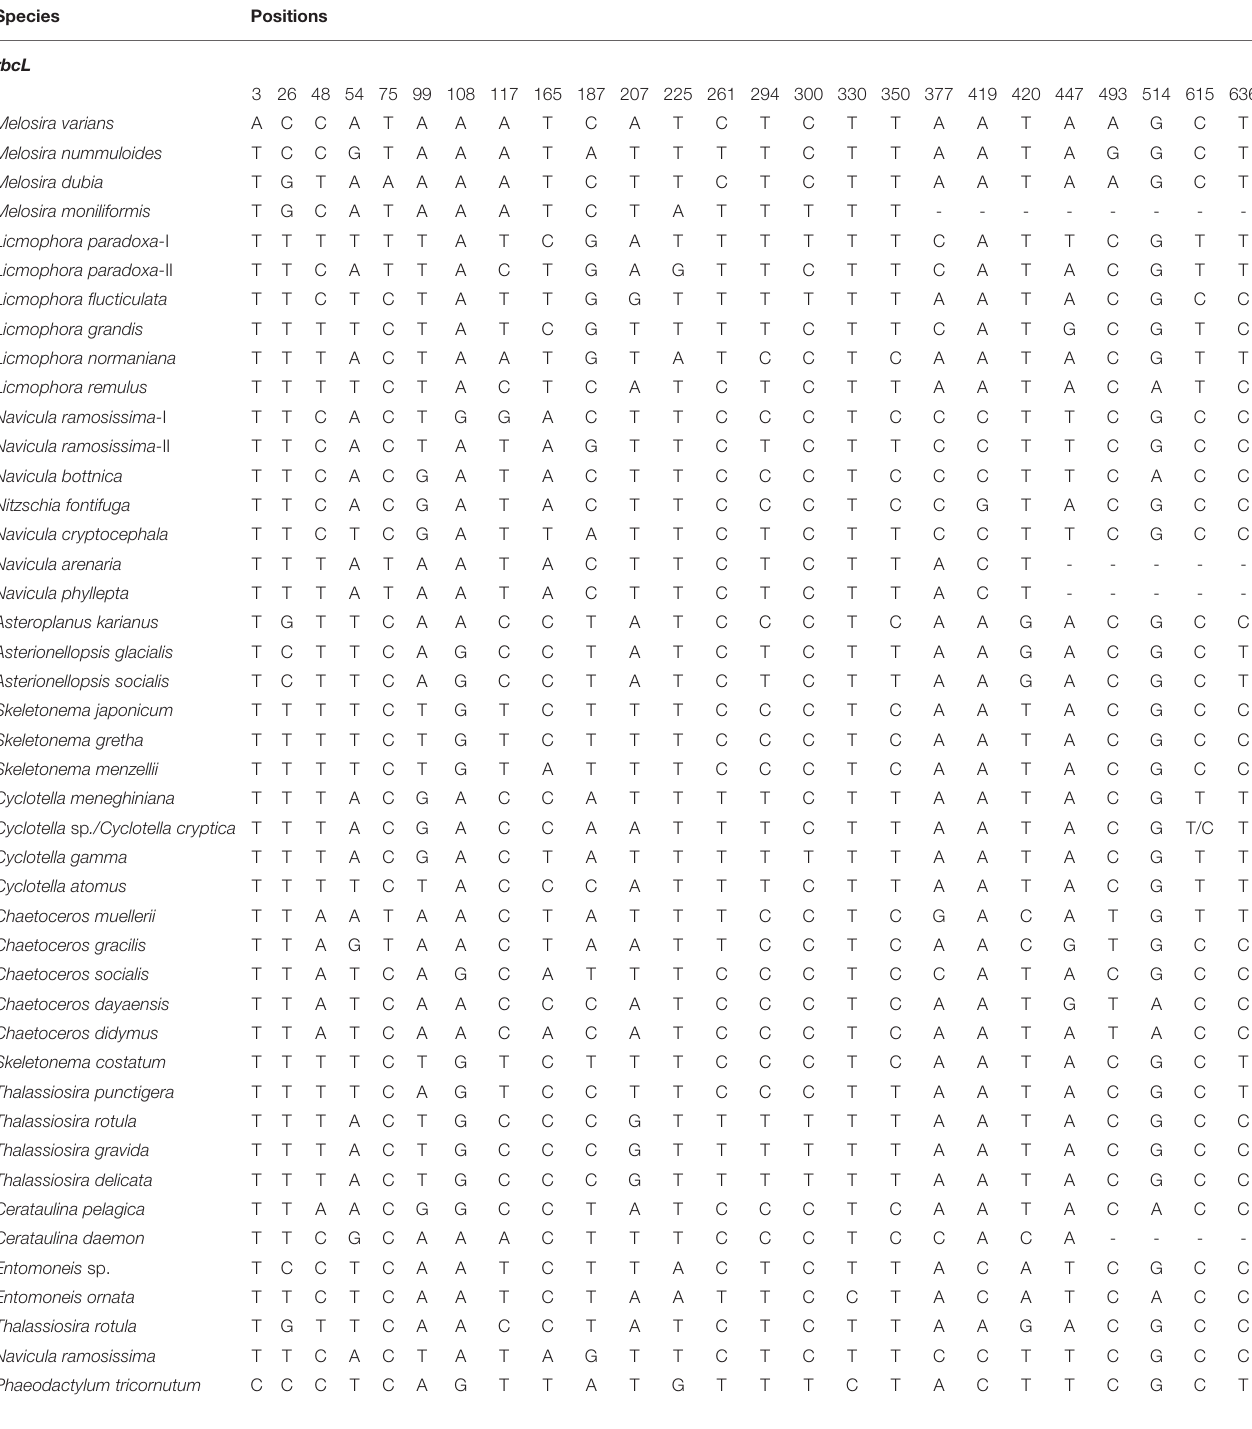
TABLE 2 | Combinations of diagnostic nucleotides for species assignments in Figure 3 (LSU and SSU) by Characteristic Attributes Organization System (CAOS) analysis. Species Positions rbcL Melosira